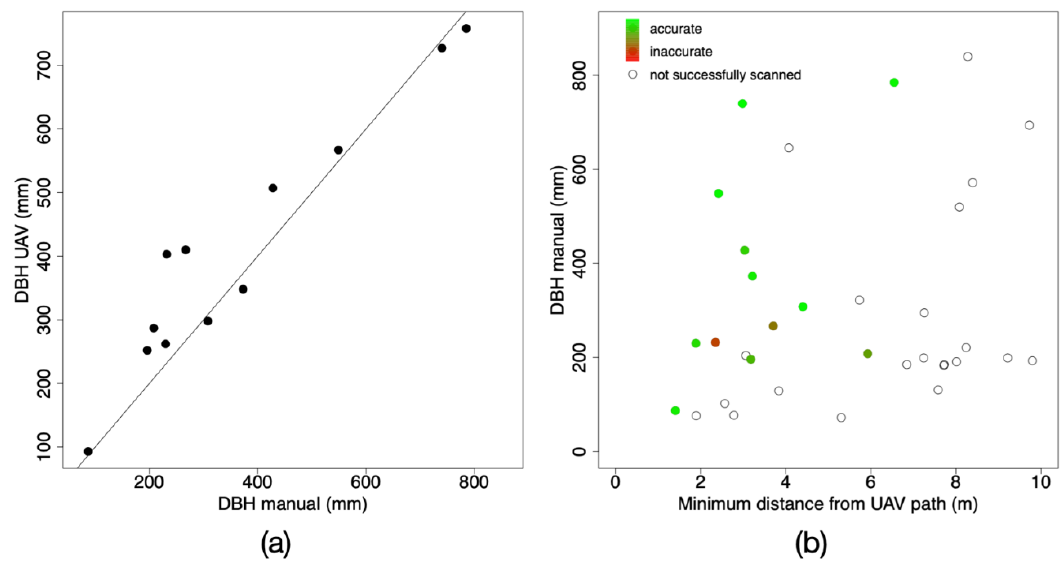
Figure 4. Results of DBH measurements: ( a ) the UAV-based DBH measurements were highly correlated with the manual